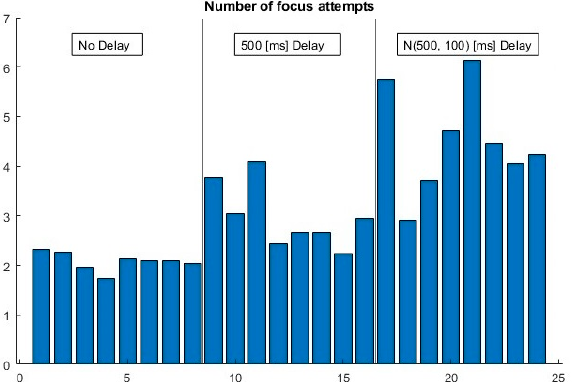
Figure 10. Number of times that the element was focused until it moved to the next position.